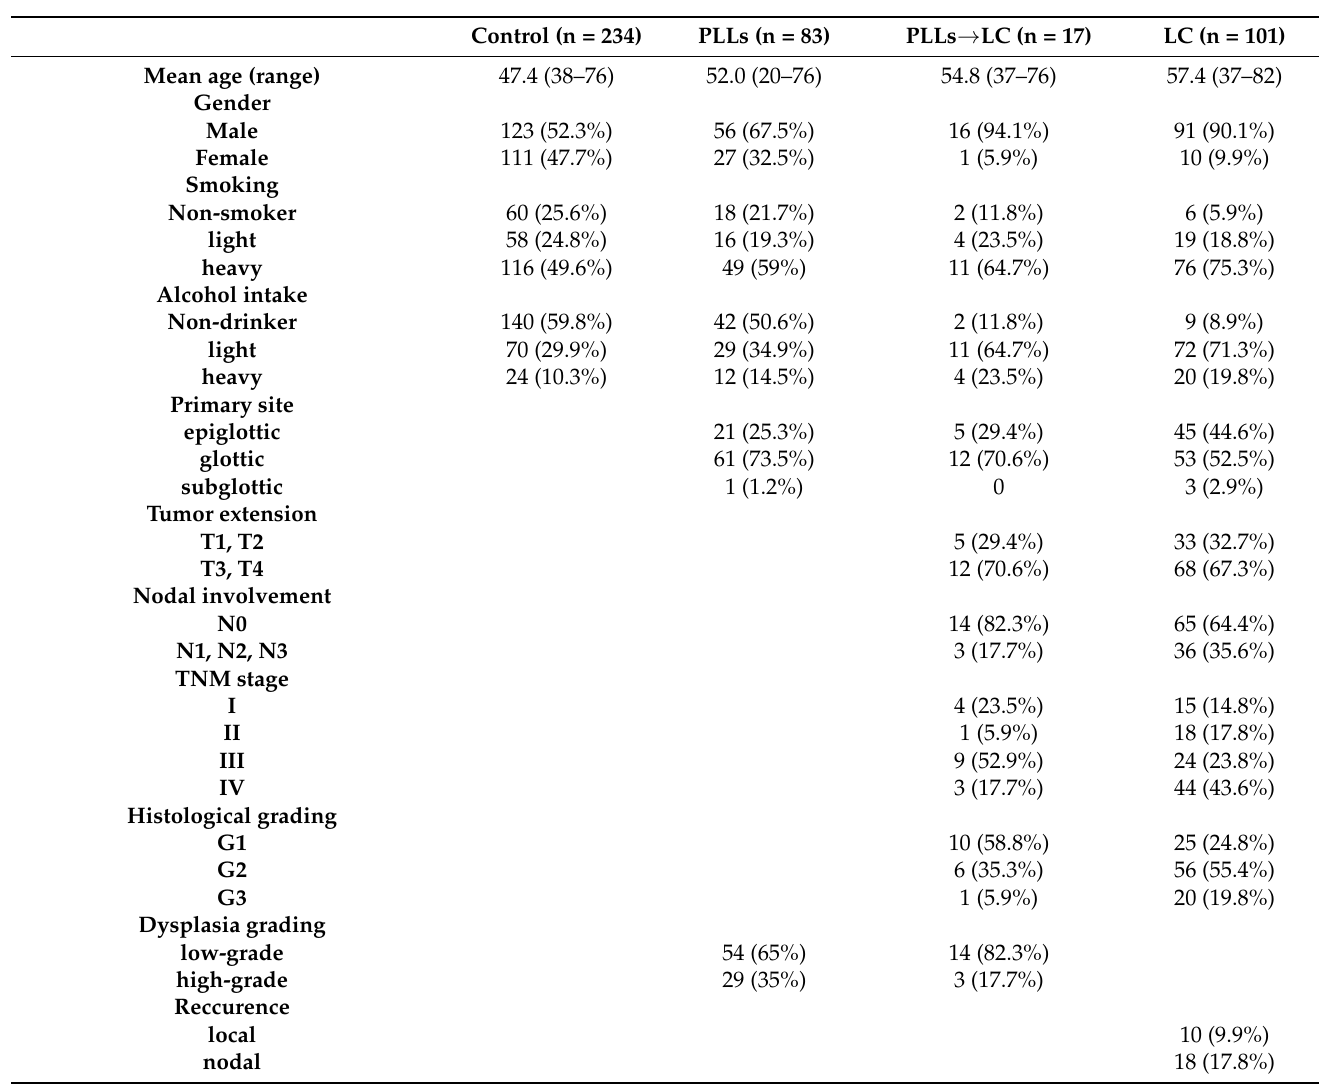
Table 1. Characteristics of examined groups of patients with premalignant laryngeal lesions (PLLs) and laryngeal cancer (LC) (PLLs → LC—PLLs with progression to LC). Control (n = 234) PLLs (n =